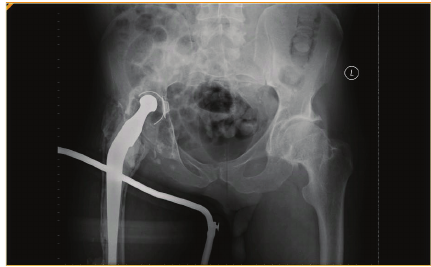
Figure 2: AP pelvis—periprosthetic fracture in Thomas splint demonstrating acetabular loosening.